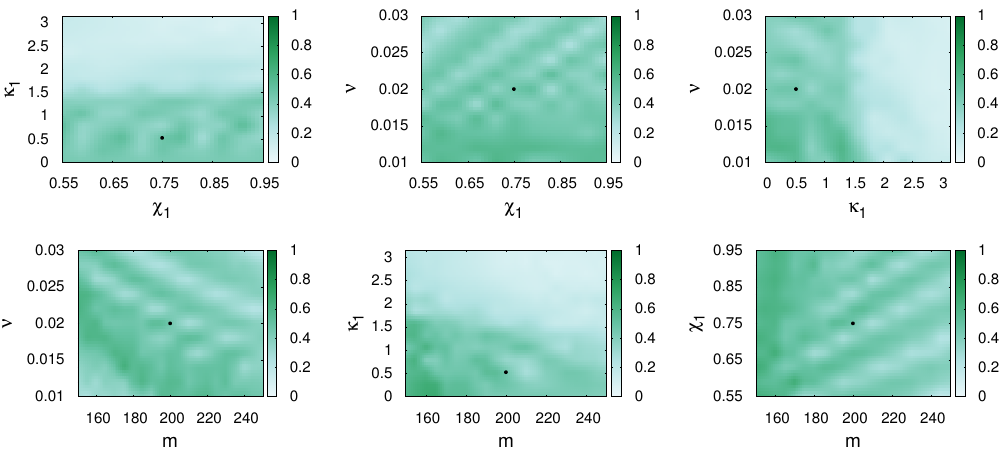
Figure 5. SEOBNRv3 is matched with itself and and match values M are presented in different parameter planes ( κ 1 , χ 1 ), ( ν , χ 1 ), ( ν , κ 1 ), ( ν , m ), ( κ 1 , m ) and ( χ 1 , m ). The parameters of the first waveform (the template) are varied, while those of the second waveform (the signal, represented by a dot) are fixed as m = 200 M (cid:12) , ν = 0.02, χ = 0.75 and κ 1 = 0.5. The other parameters were chosen as f low = 10 Hz, ι = 0.5. Spins are precessing in this case.